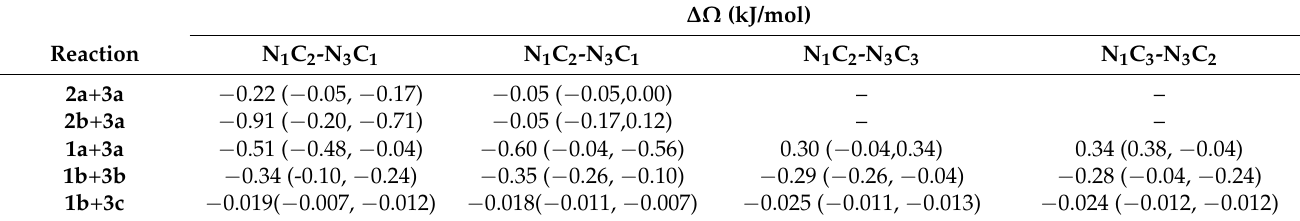
Table 4. Interaction grand potential ∆Ω (kJ/mol) at the transition state of the investigated cycloadditions, calculated at the M08-HX/pcseg-3//M08-HX/pcseg-2 level. The bond contributions are reported in brackets, ordered as in the column headings.